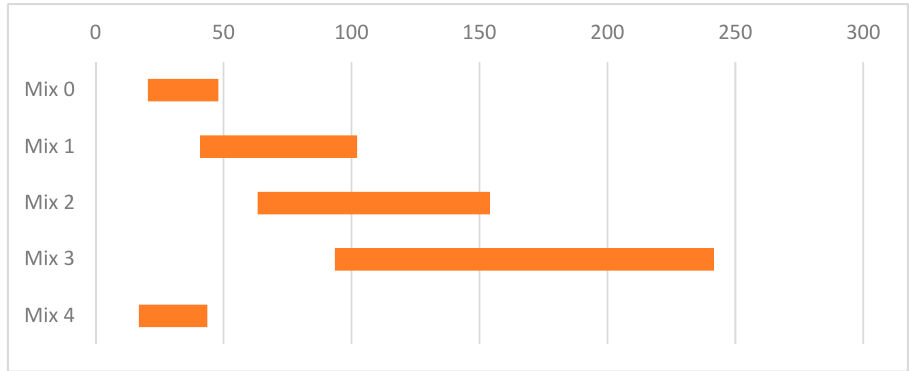
Figure 4. Cost price ranges for different material mixes [USD/t] (wet tonne).